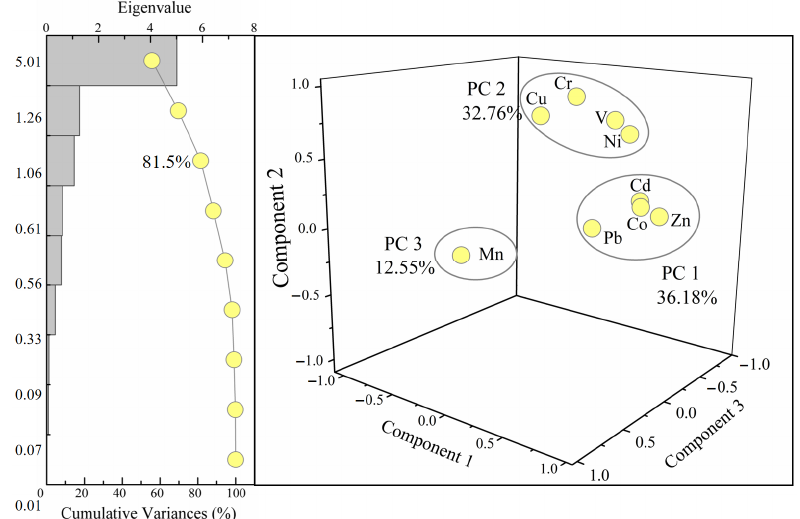
Figure 4. PCA results of factor loadings of PTEs of SPM in Jiulongjiang River.3.4. PTEs’ Behavior between Dissolved, Suspended and Sediment Phases.